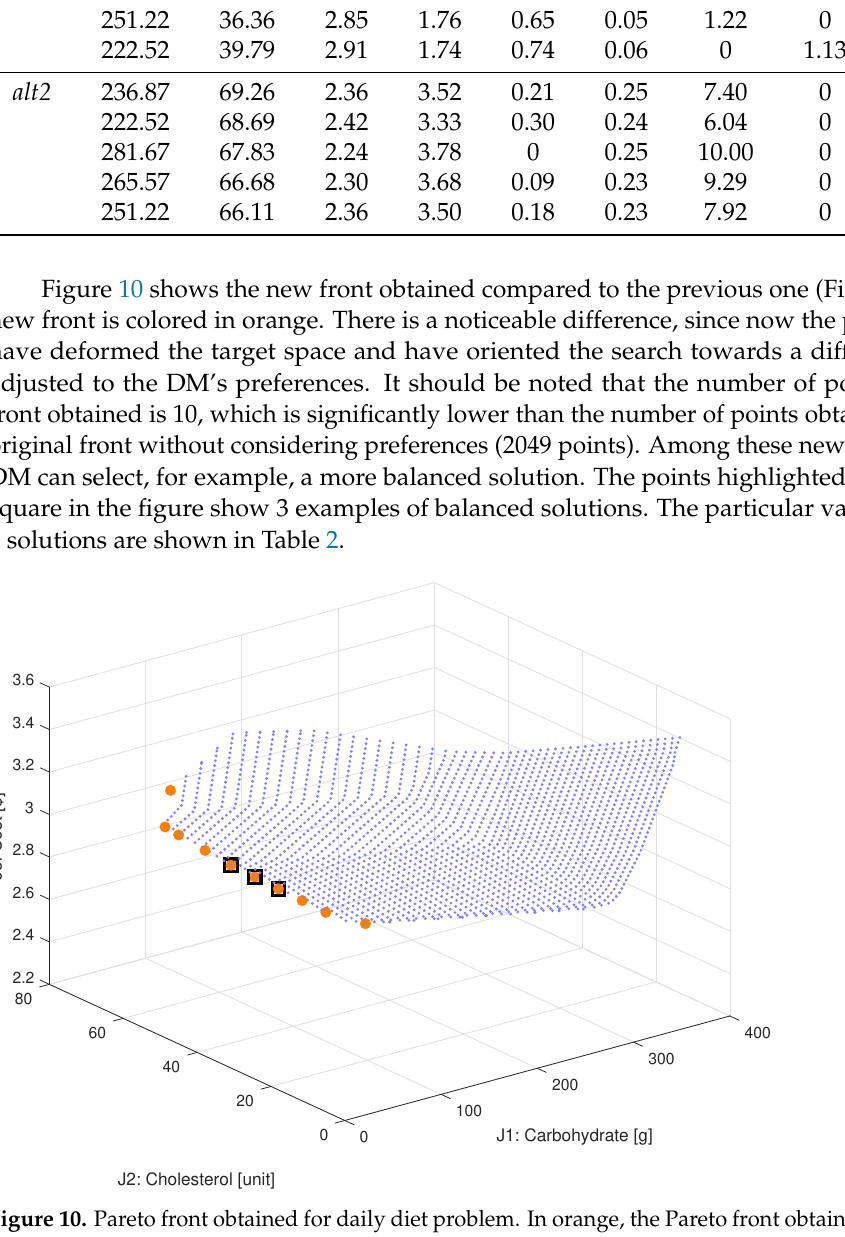
Figure 10. Pareto front obtained for daily diet problem. In orange, the Pareto front obtained including preferences into the optimization problem resolution. In blue, the original Pareto front obtained without preferences. Black square shows 3 balanced